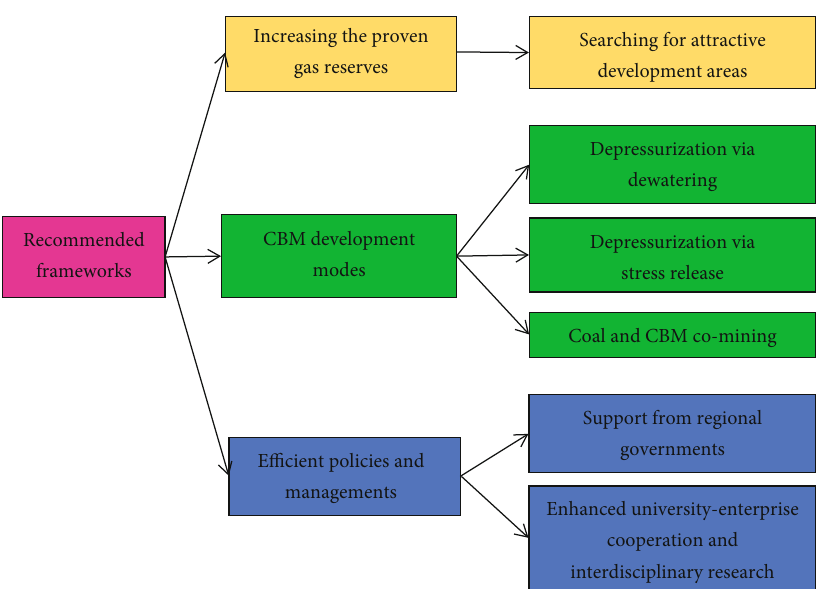
Figure 5: Recommended framework for CBM